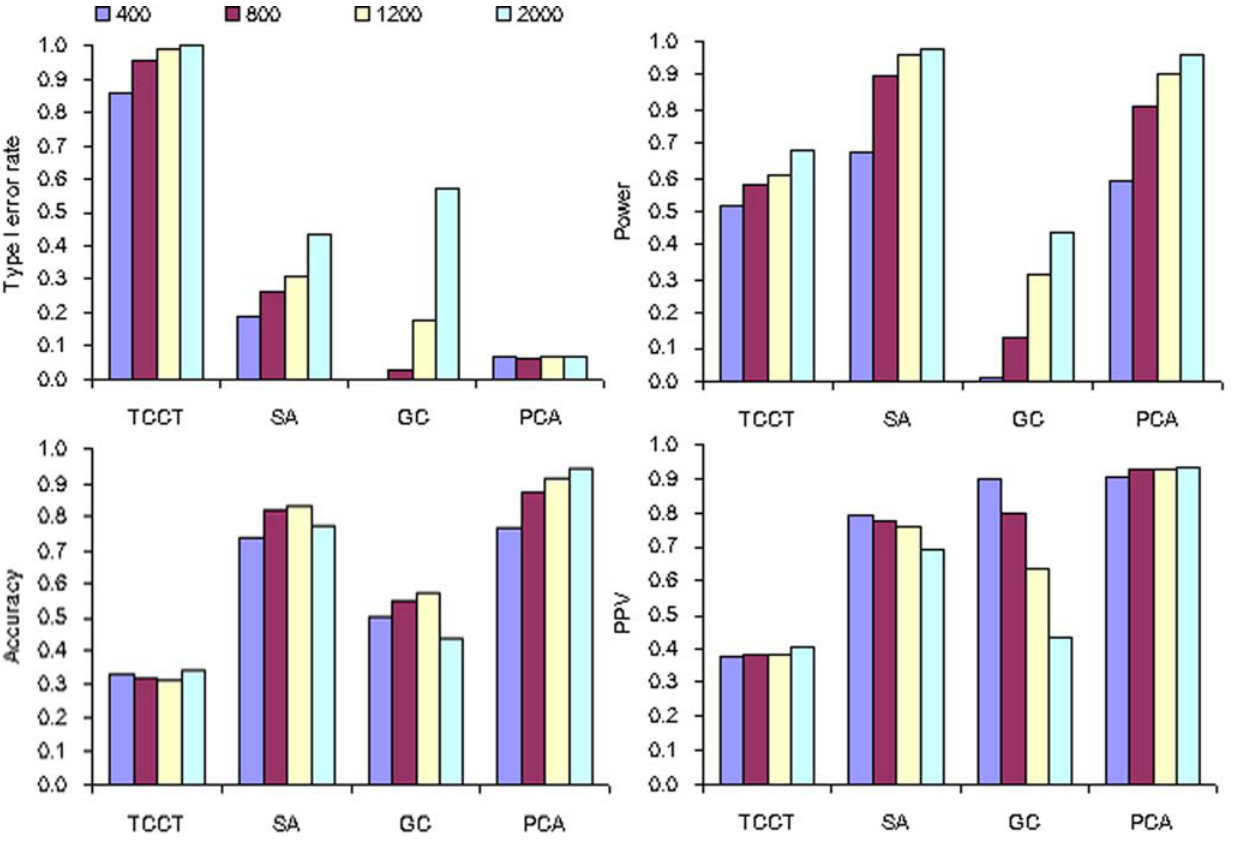
Figure 2. Performance of the four analytical methods in stratified populations with sample sizes varying from 400 to 2000 (stratification level=0.5 2 0.1, frequency of disease susceptible allele=0.20 6 0.02 and number of AIMs=40).